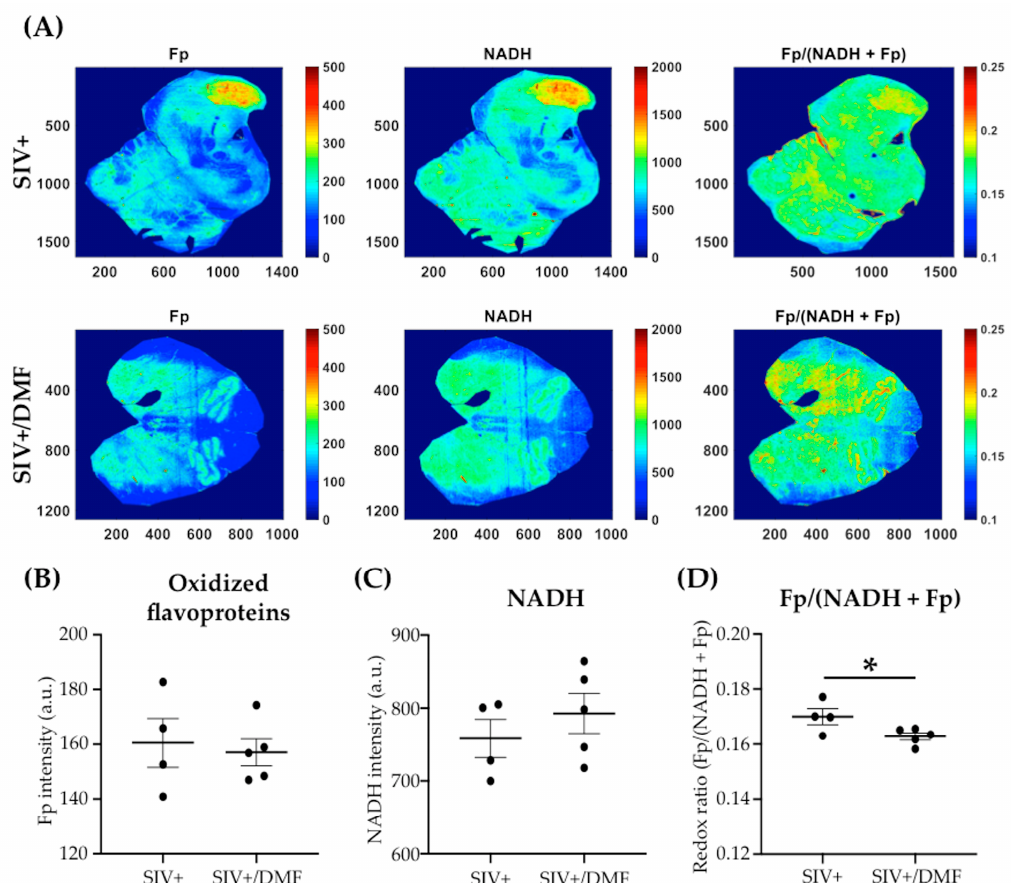
Figure 8. DMF treatment was associated with a lower redox ratio Fp/(NADH + Fp) in the brainstem of SIV-infected macaques. ( A ) Representative images (brainstem) of the autofluorescence of Fp (left), NADH (center), and Fp/(NADH + Fp) (right). The “ x ” and “ y ” coordinates of the image matrices are shown. Numbers and color bars on the right of each image indicate the range of the redox index being displayed. ( B ) Quantification of the Fp autofluorescence showed no significant change in Fp levels with DMF treatment (statistical analysis was done with Student’s unpaired t -test). ( C ) No significant difference in NADH levels was observed with DMF treatment. ( D ) Quantification of Fp/(NADH + Fp) showed that the DMF treatment was associated with a lower redox ratio, which was indicative of a lower oxidative stress level (statistical analysis was done with Student’s unpaired t -test, * p < 0.05). Nine SIV-infected rhesus macaques were used in the study (four untreated animals and five DMF-treated (90 mg total DMF daily)). Intensities are in arbitrary units (a.u.) and all redox indices are expressed as the mean ± SEM.